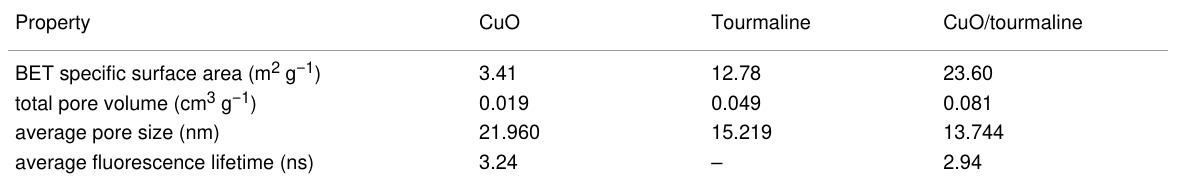
Table 1: BET specific surface area, total pore volume, average pore size, and average fluorescence lifetime of the samples.